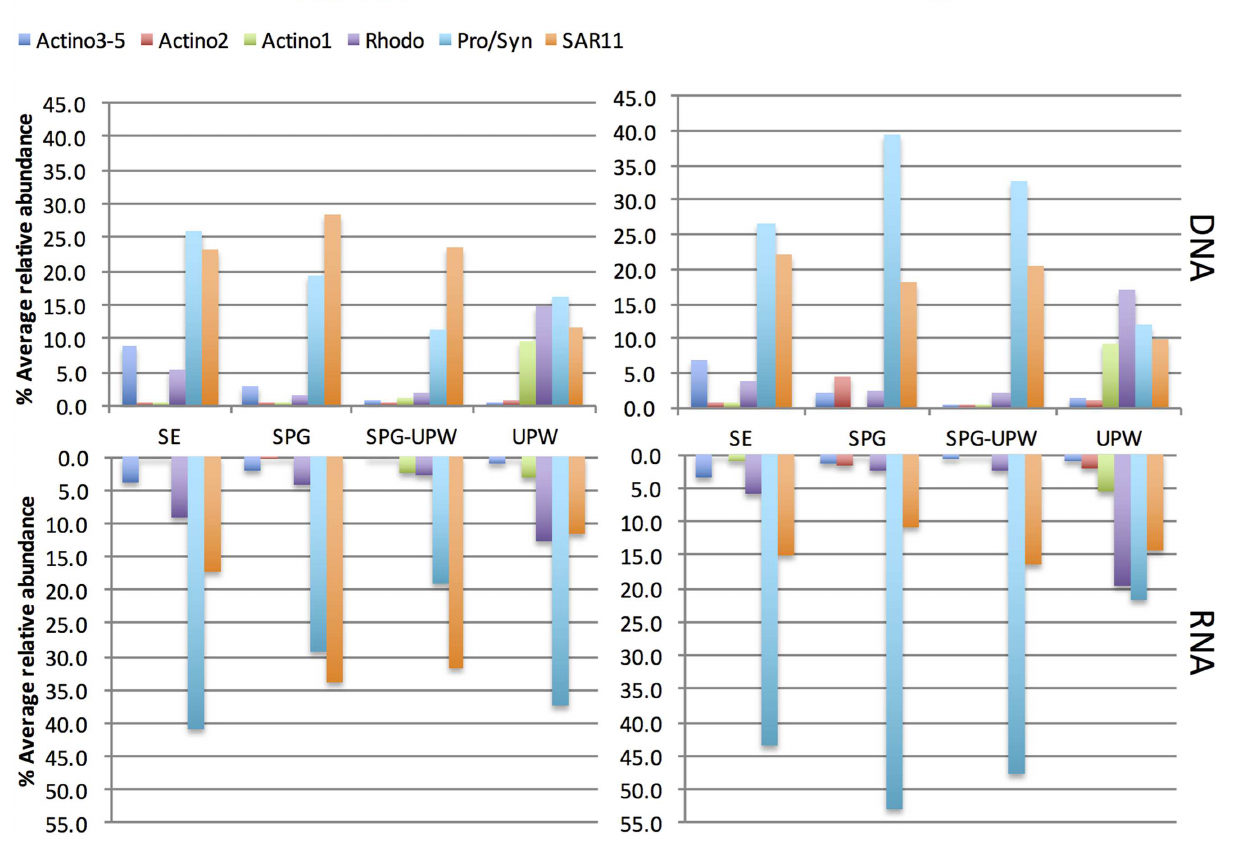
FIGURE 5 | Relative abundance of assigned SSCP peaks at surface or DCM depths in the RNA and DNA profiles averaged for the stations attributed to the four different water masses. The Prochlorococcus / Synechococcus (Pro/Syn), SAR11 and Rhodobacteraceae (Rhodo) abundances are each composed of two